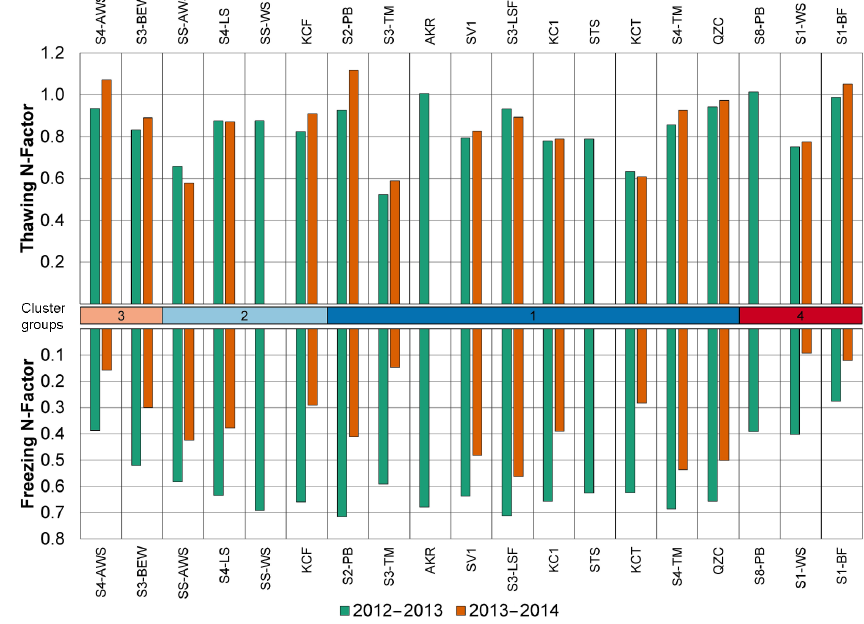
Figure 7. Thawing n factors (top panel) and freezing n factors (bottom panel) for each site and measurement period.